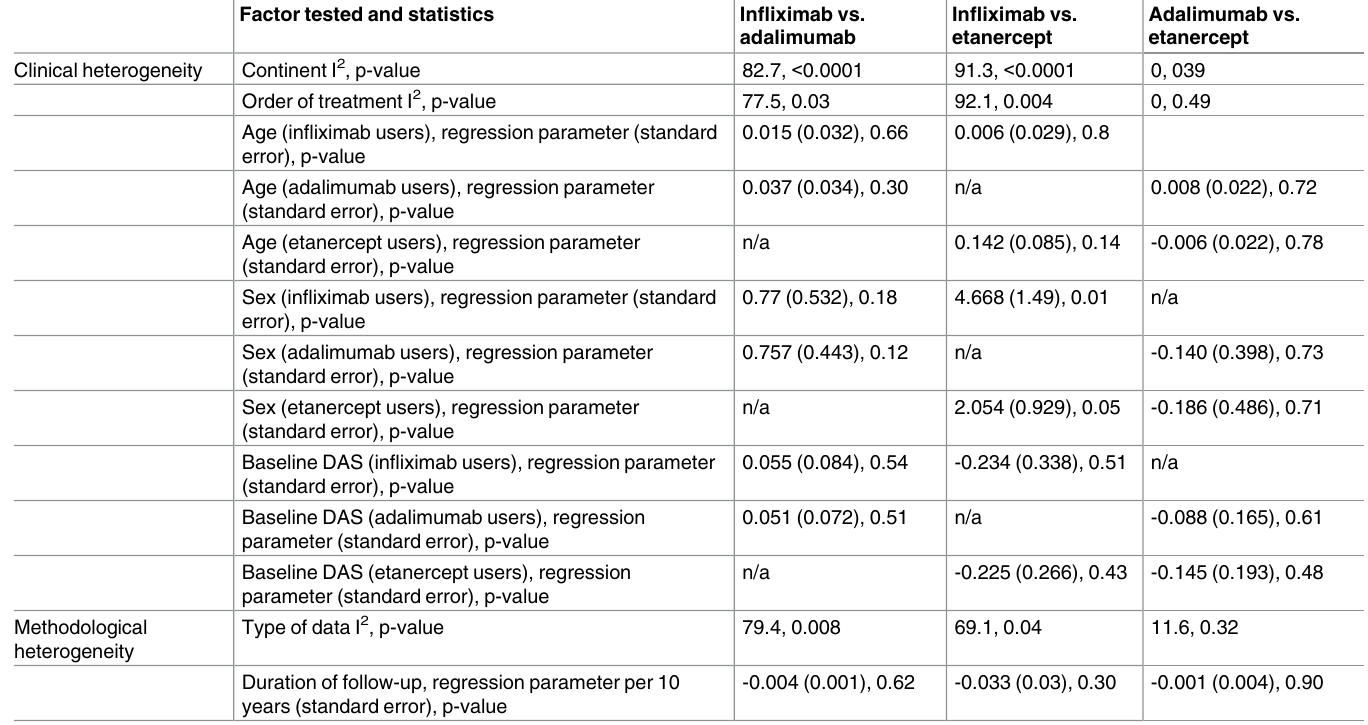
Table 2. Assessment of heterogeneity: association between study design and patient characteristics and effect sizes. Factor tested and